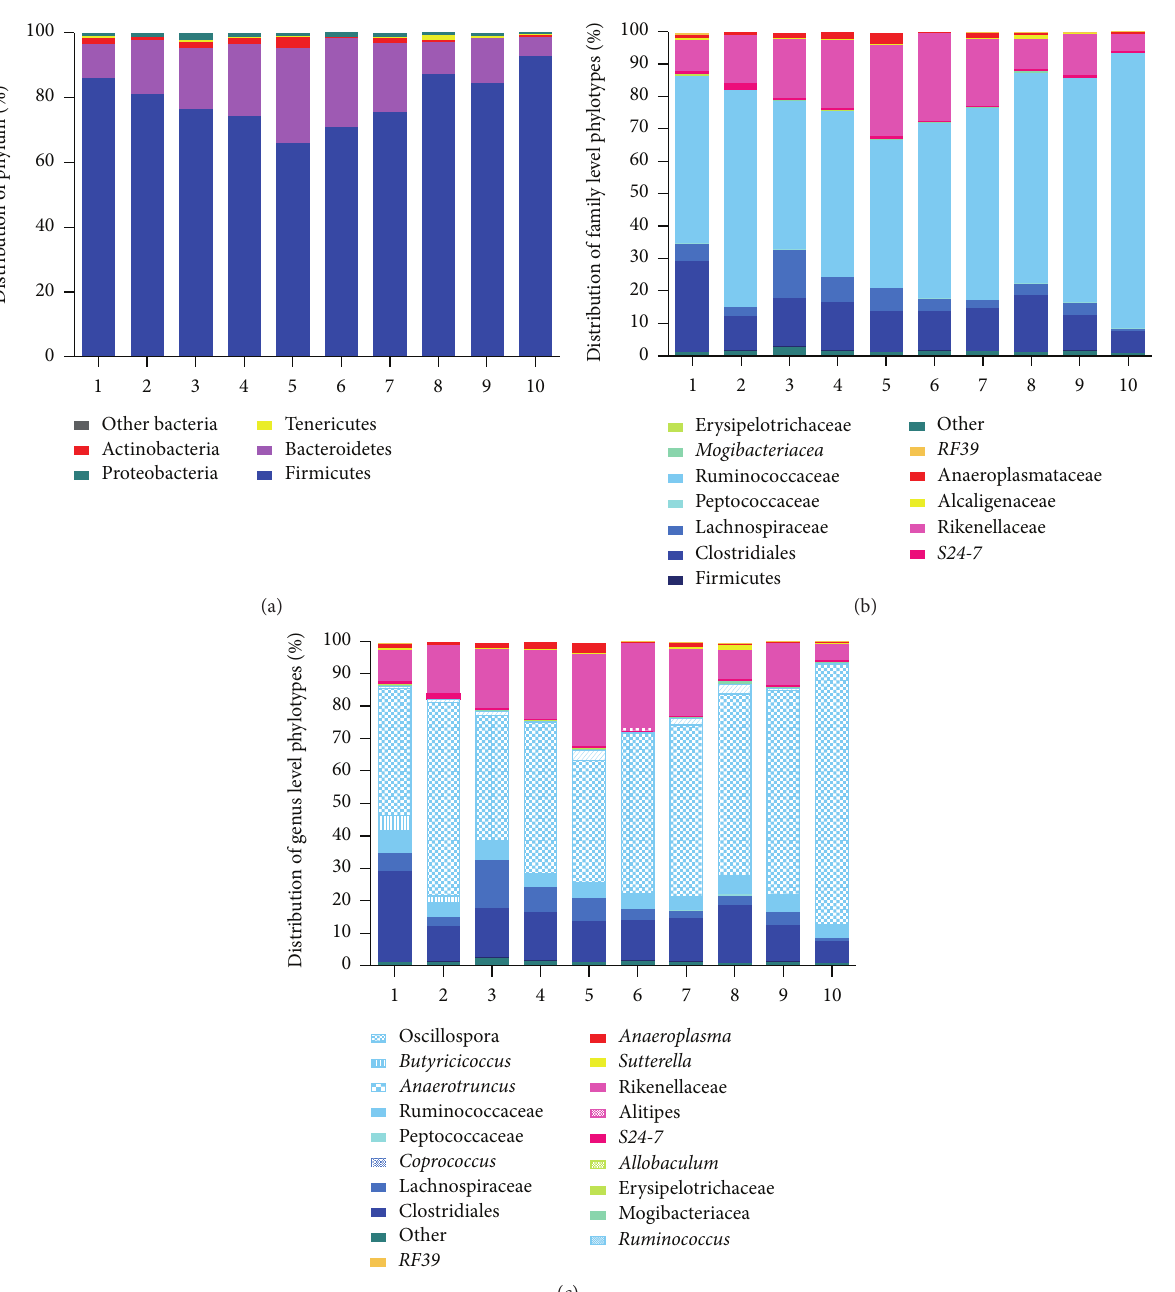
Figure 5: Bacterial community profiling at the phylum (a), family (b), and genus (c) level phylotypes of fecal samples from 10 mice cohoused in the same cage, showing the huge interindividual